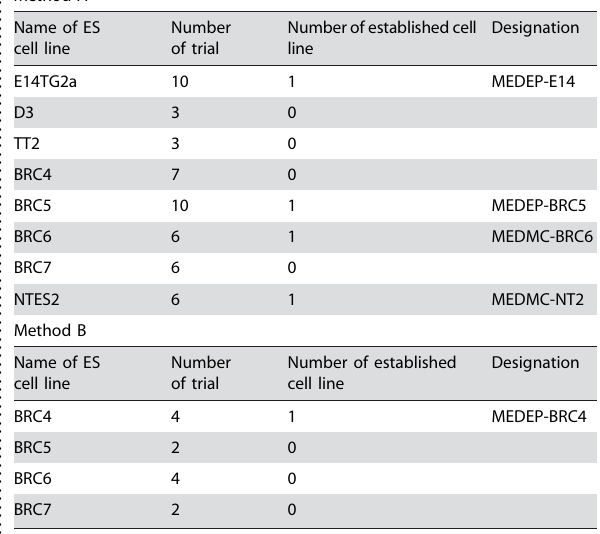
Table 2. The number of trials to establish cell lines and